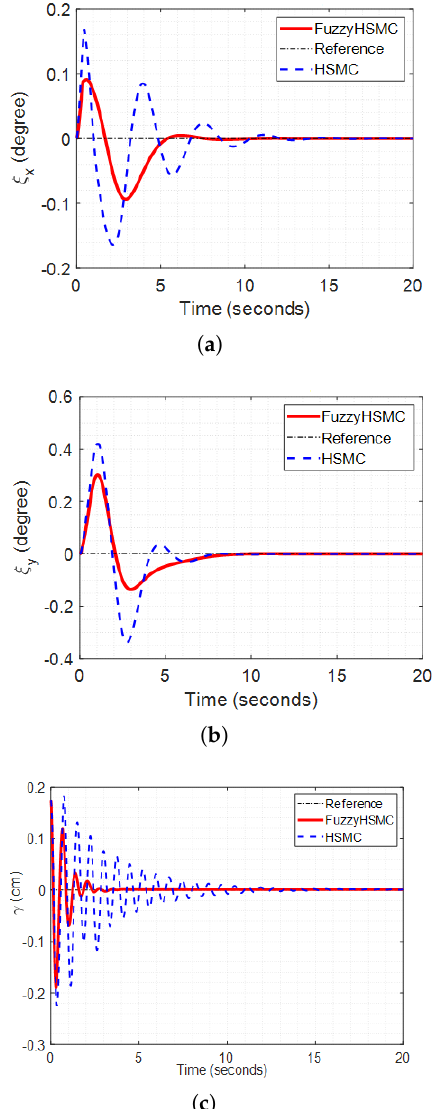
Figure 5. The under-actuated states given the constant input. ( a ) The sway of the payload in Oxz , ξ x ( t ) . ( b ) The sway of the payload in Oyz , ξ y ( t ) . ( c ) The oscillation of the hoisting cable in the cable direction, γ ( t )